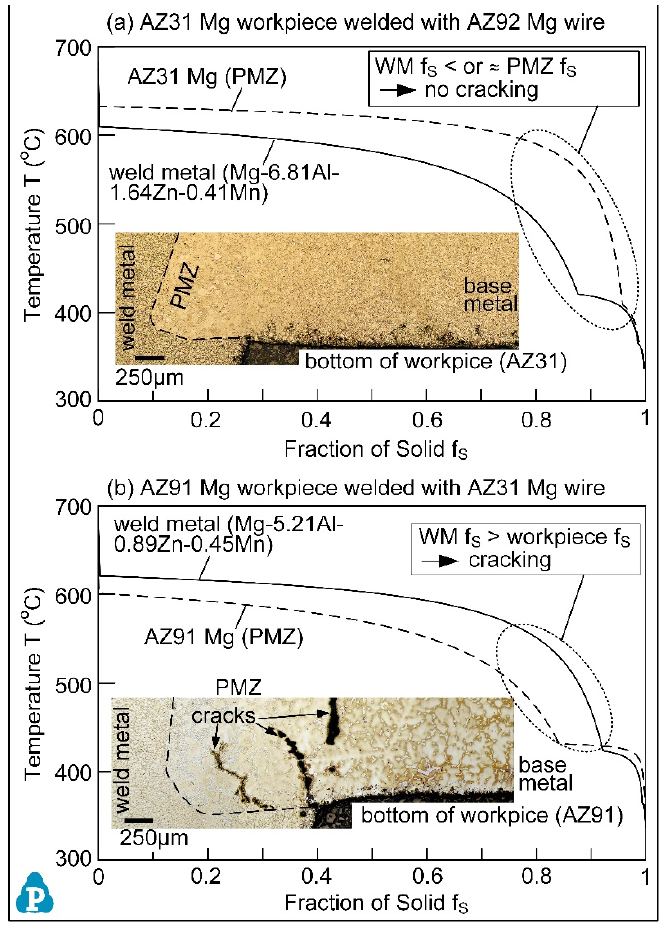
Figure 5. Susceptibility of Mg alloys to liquation cracking in circular-weld testing: ( a ) AZ31 Mg welded with AZ92 as filler metal; ( b ) AZ91 welded with AZ31 Mg as filler metal. Chai, Yuan, and Kou data from [34].